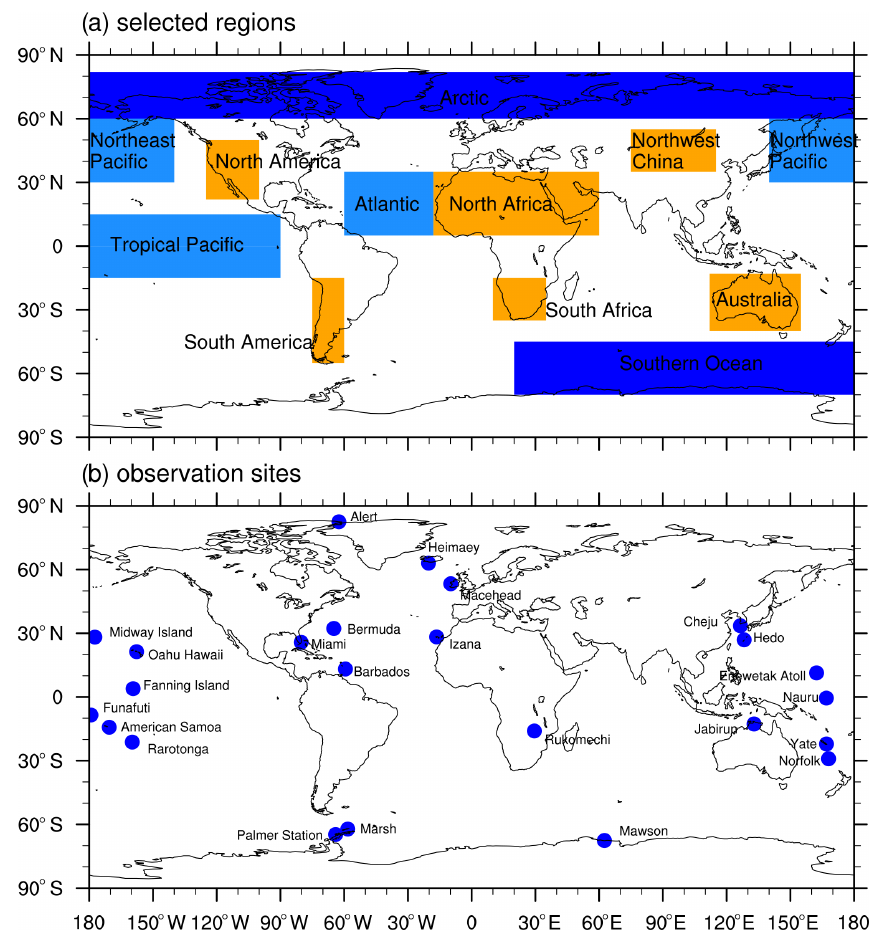
Figure 1. Illustration of (a) 12 selected domains and (b) network of stations measuring dust surface